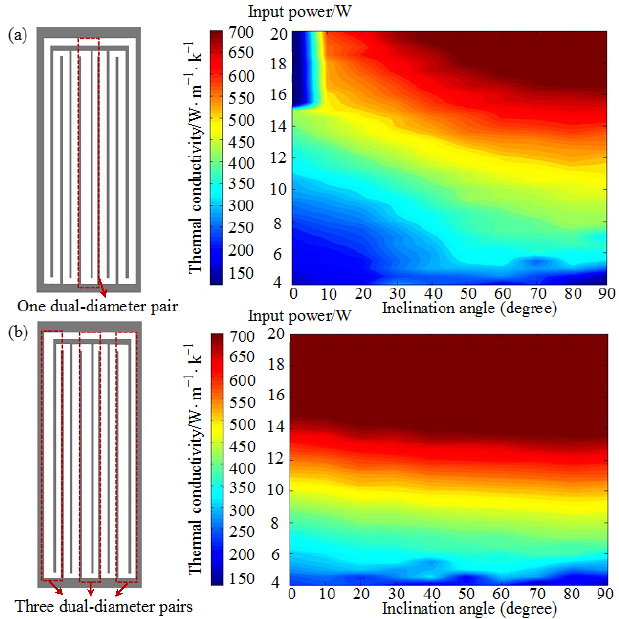
Figure 9. The thermal conductivity of MPHP affected by gravity: The MPHP has ( a ) one dual-di- ameter pair and ( b ) three dual-diameter pairs [102]. Kwon et al. (2015). diameter pair and ( b ) three dual-diameter pairs [102]. Kwon et al.